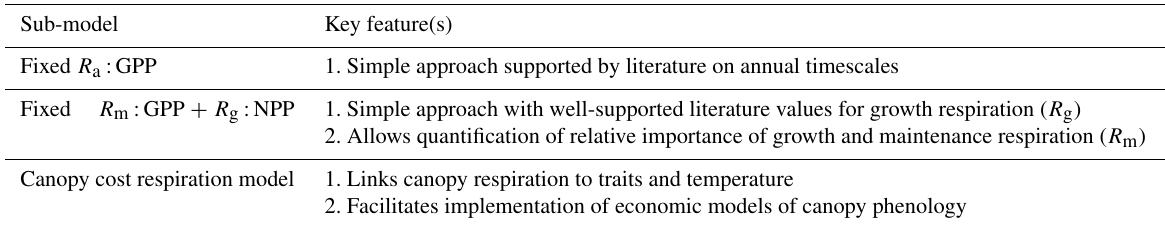
Table A2. Summary of key features for each respiration sub-model. Sub-model Key